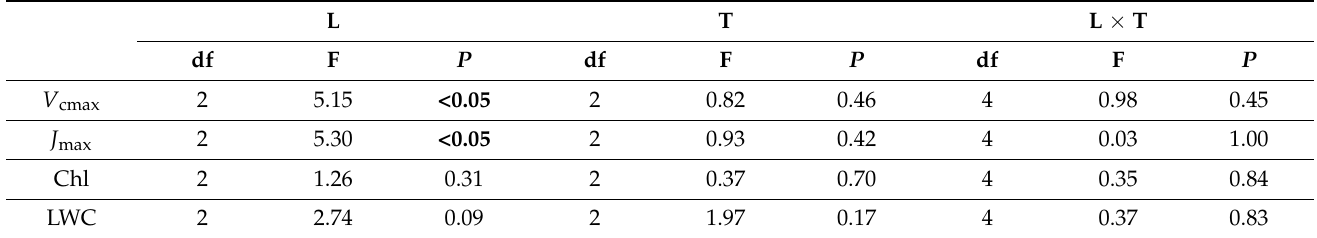
Figure 4. Relationships between P n of different periods and LCO of Quercus mongolicus seedlings. Table 3. Effects of photoperiod (L), temperature (T), and their interaction on photosynthetic param ‐ eters, leaf chlorophyll content, and water content near LCO.